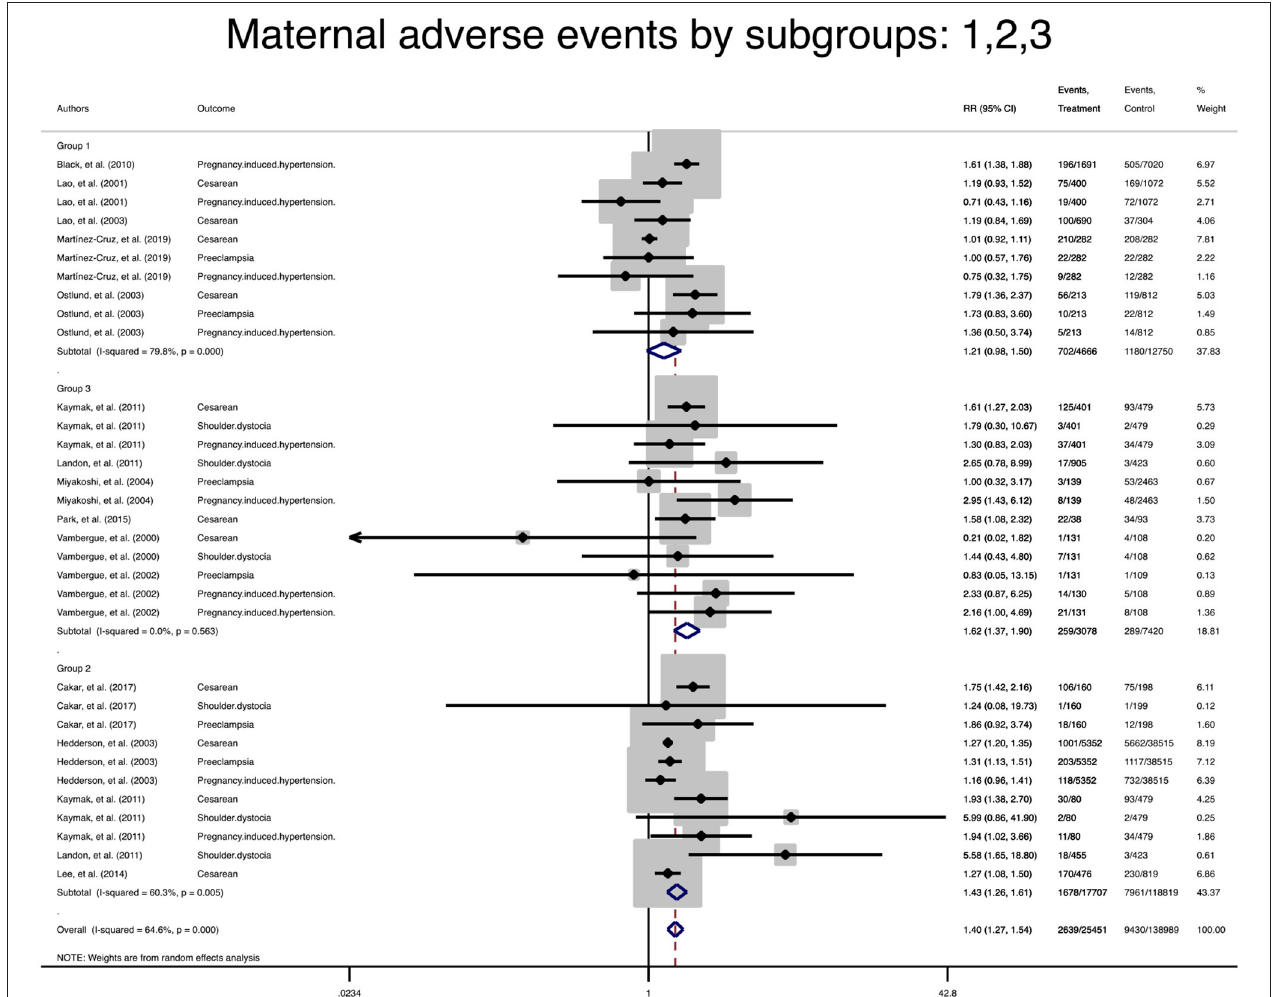
FIGURE 4 | Forest plot of pooled relative risk of adverse maternal events in subgroups.